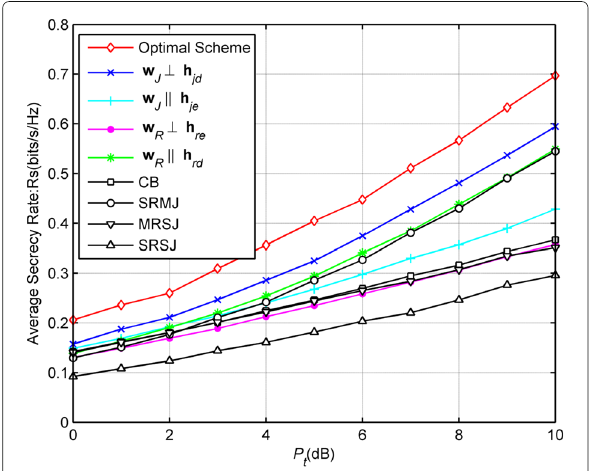
Fig. 3 The average secrecy capacity versus total transmit power of relays, P s = 0 dB, N =